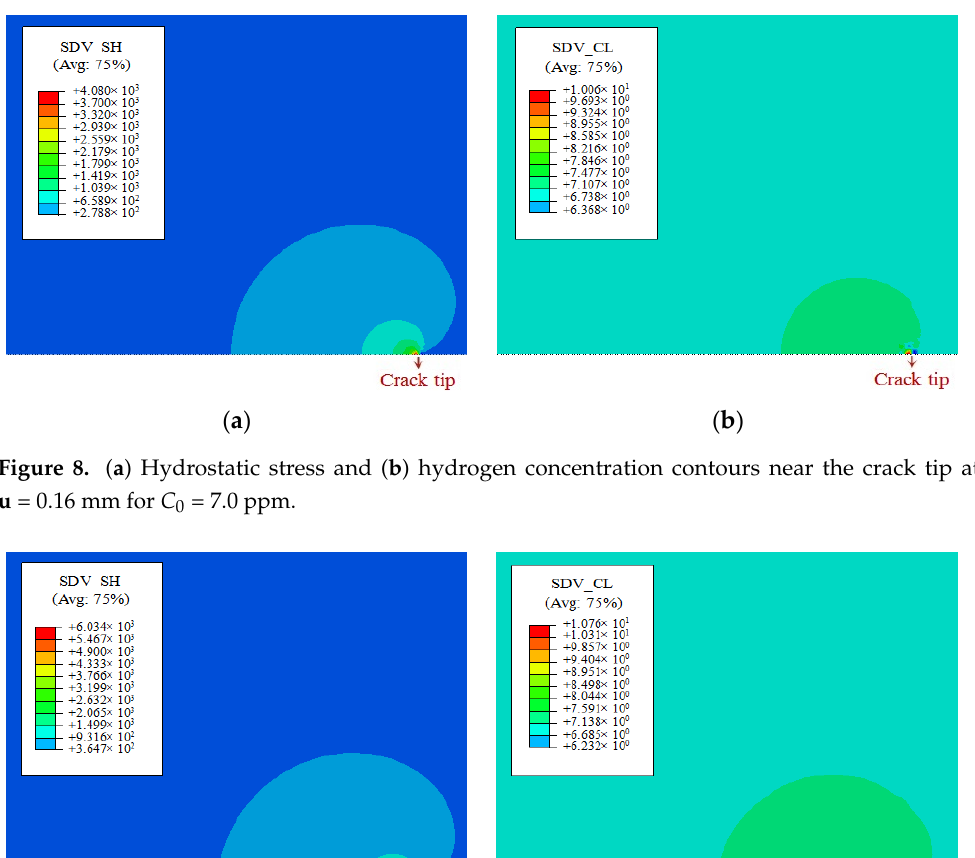
Figure 7. ( a ) Hydrostatic stress and ( b ) hydrogen concentration contours near the crack tip at u = 0.10 mm for